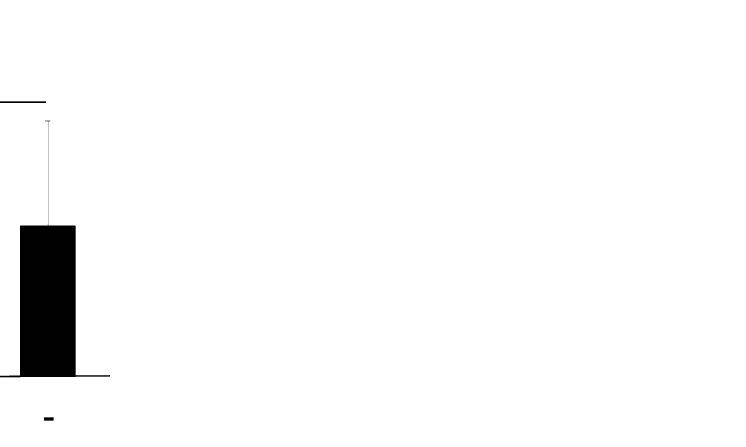
Figure 3. Relationship between the postoperative retinal structure and postoperative best-corrected visual acuity (BCVA) in eyes with rhegmatogenous retinal detachment. The postoperative BCVA is significantly better in the group with ellipsoid zone (Ez) continuity than in the group without Ez continuity. Eyes with postoperative subretinal fluid are excluded from this analysis. logMAR: logarithm of the minimum angle of resolution; * P <